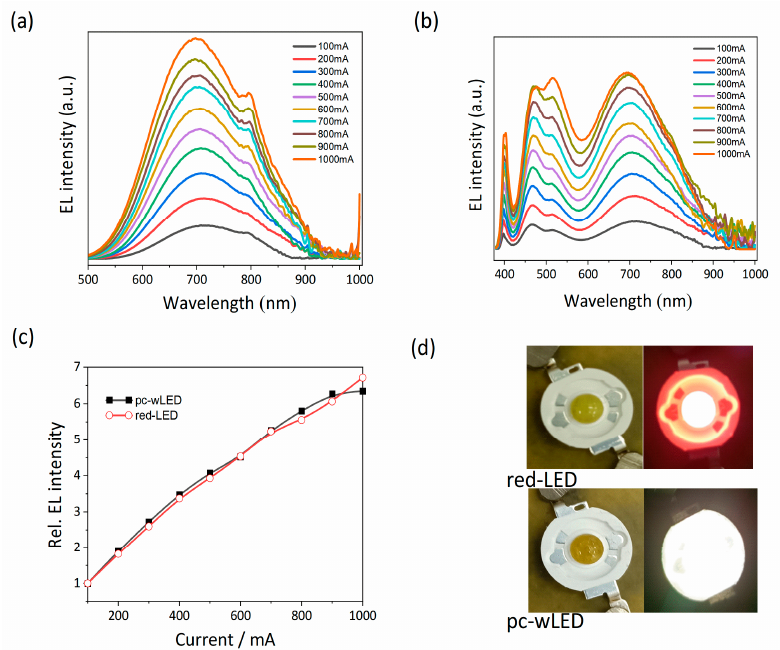
Figure 4. ( a ) Electroluminescence spectra of [bppmCu 2 I 2 ] 2 -based single-component LED at high flux operating currents of 100–1000 mA. ( b ) Electroluminescence spectra of [bppmCu 2 I 2 ] 2 -based